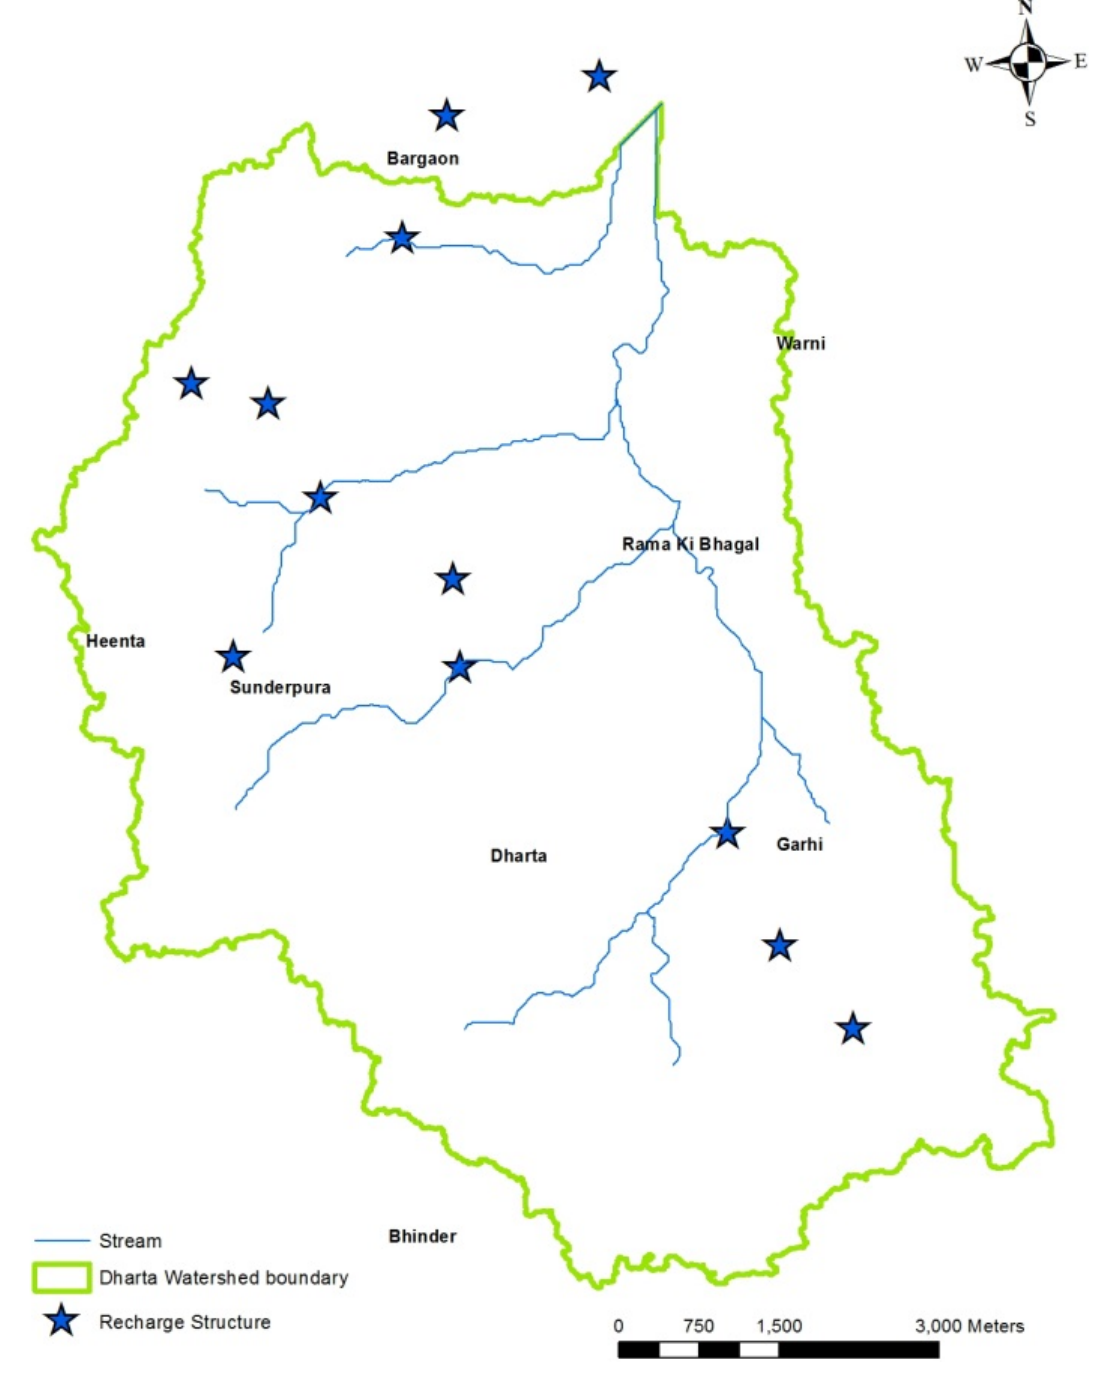
Figure 3. Location of MARs in the Dharta